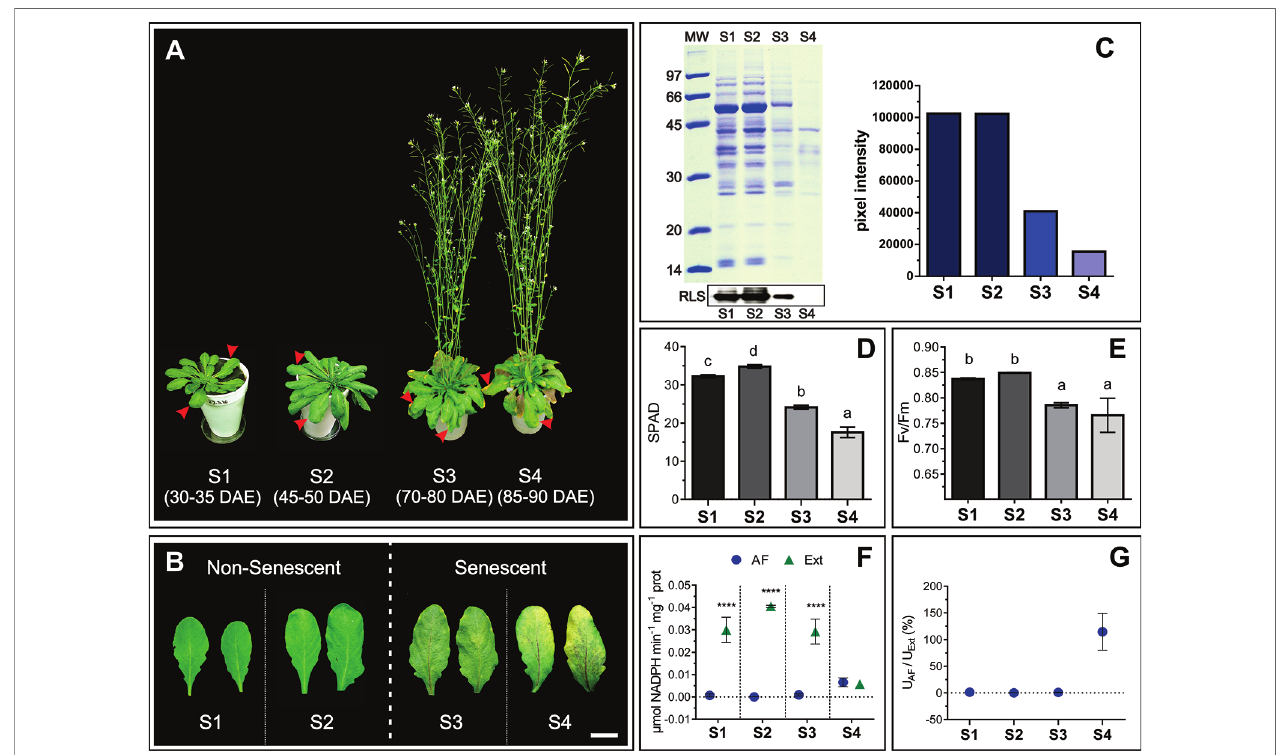
FIGURE 1 | Physiological characteristics of S1, S2, S3, and S4 leaves. (A) Leaf stages, marked with red arrows, DAE: Days after emergency. (B) Mature, non- senescent leaves (S1 and S2) and senescent leaves (S3 and S4), scale bar 2 cm. (C) Leaf protein content: Representative SDS-PAGE showing a total protein pro fi le loaded per unit leaf area, and immunodetection of Rubisco Large Subunit (RLS), in the left upper and lower panel, respectively. Relative leaf protein content, considering S1 as maximum, was estimated by densitometric analysis of the SDS-PAGE, and it is shown on the right panel. (D) Chlorophyll content per unit leaf area expressed in SPAD units. (E) Maximum quantum yield of Photosystem II (Fv/Fm). (F) Enzymatic activity (U) of the cytosolic enzyme G6PDH in apoplastic fl uid (AF) and total leaf extracts (Ext) expressed on the basis of total protein (prot) content. (G) Percentage of G6PDH activity in AF as a function of G6PDH activity in Ext. Values in the graphs show the average ± standard error, SEM, of independent measurements. Data were normally distributed. SPAD readings were taken in 10 to 15 different leaves for each stage, two readings per leaf blade. Fv/Fm values are the average of 16 leaves (S1), 30 leaves (S2 and S3), and six different S4 leaves, one reading per leaf blade. G6PDH activity (D and E) represents the average of biological samples (n), where each FA and Ext biological sample was made up of at least 4 leaves. S1: n = 6 FA and Ext n = 6, S2: n = 4 FA and n = 3 Ext, S3: n = 9 FA and n = 5 Ext, S4: n = 3 FA and 3 Ext. Signi fi cant differences were calculated at P ≤ 0.05 between the conditions using the Tukey test; letters indicate signi fi cant differences between stages. Asterisks indicate signi fi cant differences between AF and Ext; ****, P < 0.0001, calculated using a two-way ANOVA